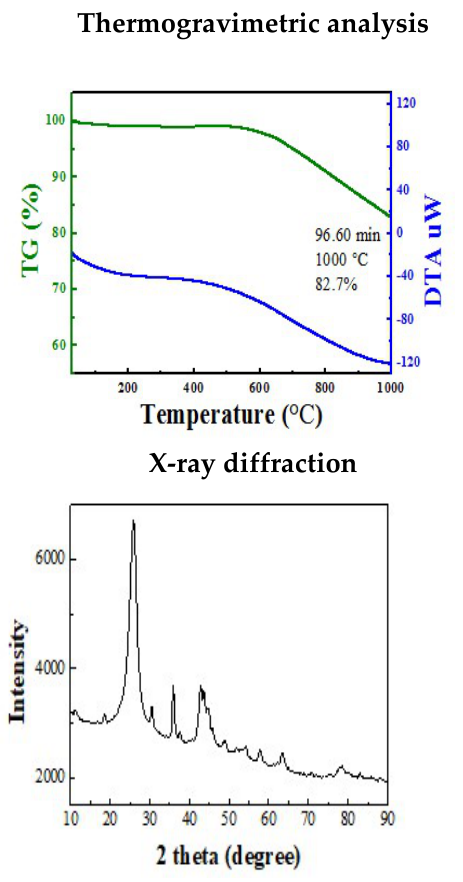
Figure 2. CNF physicochemical characteristics. Table 3. CNF mass concentrations and MMAD in exposure chamber.